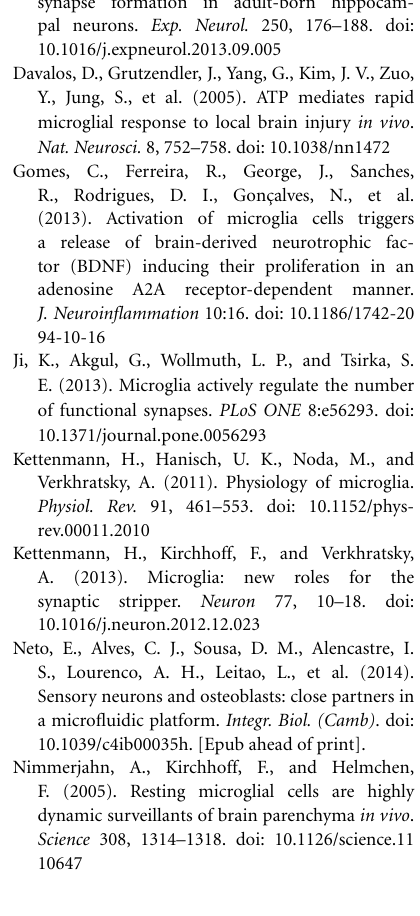
DAPI (nuclei, blue), tau (axonal marker, red), and synapsin I (synaptic vesicles marker, white). Scale bars are 10 and 5 μ m for upper and lower zoom-in images, respectively. (B) Quantification of the number of synapsin puncta per axonal length. Results, obtained analyzing 20 images per condition, are expressed as mean ± s.e.m. of three independent experiments, ( ∗ p < 0 . 5, by Two-Way ANOVA followed by Bonferroni post-hoc